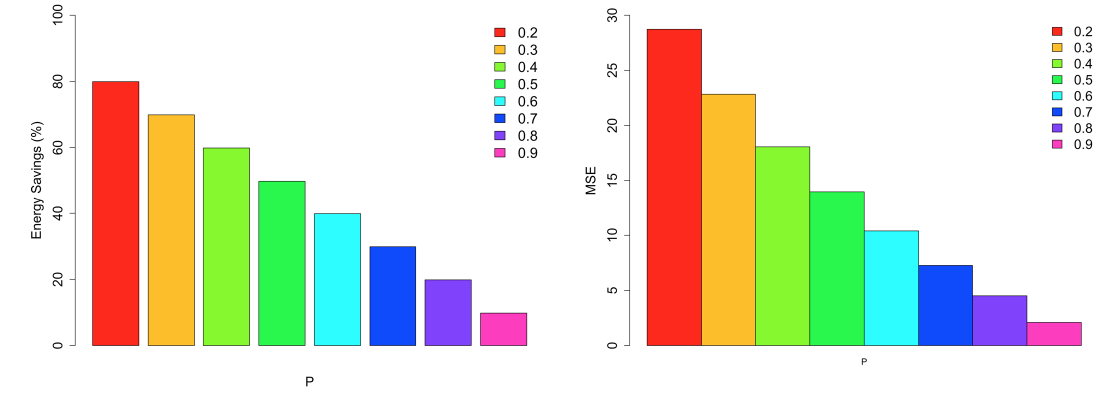
Figure 15. Energy savings and MSE of LEACH for Intel Lab Dataset